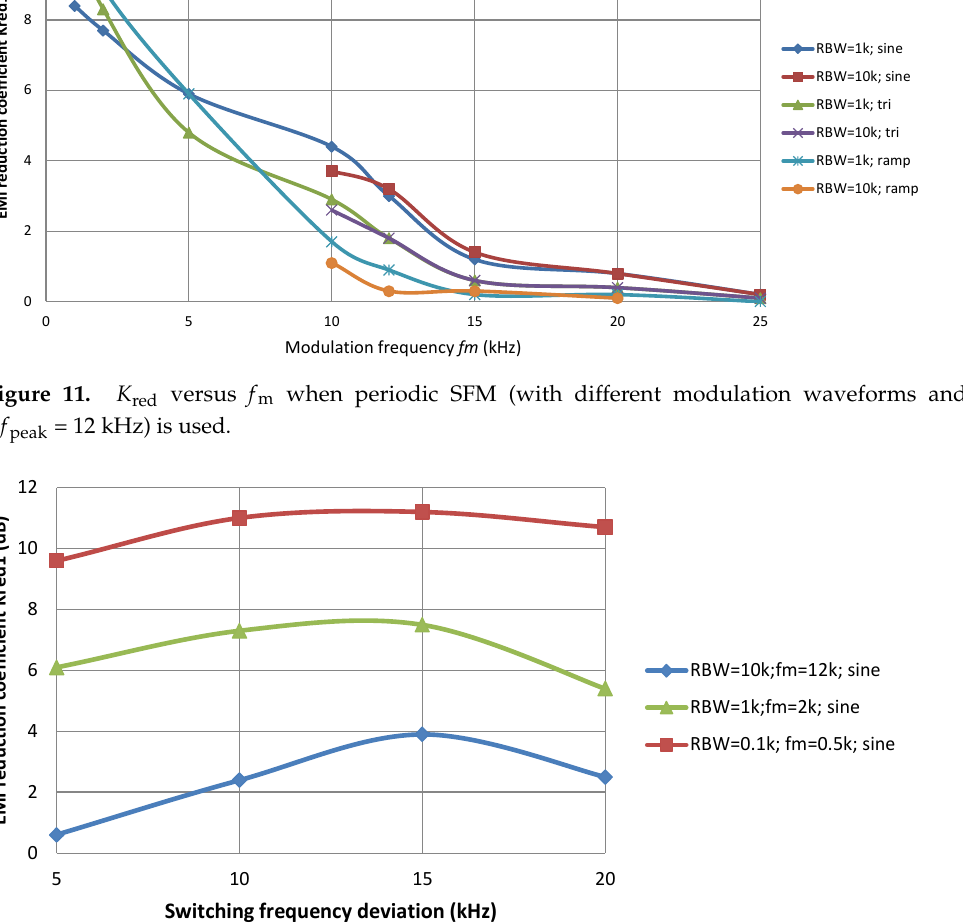
Figure 12. K red1 versus ∆ f peak when periodic SFM (with sine modulation waveform and different f m ) is used. Table 2. The third harmonic amplitude reduction coefficient ( K red3 ) as a function of f m (RBW = 1 kHz; ∆ f peak = 12 kHz).